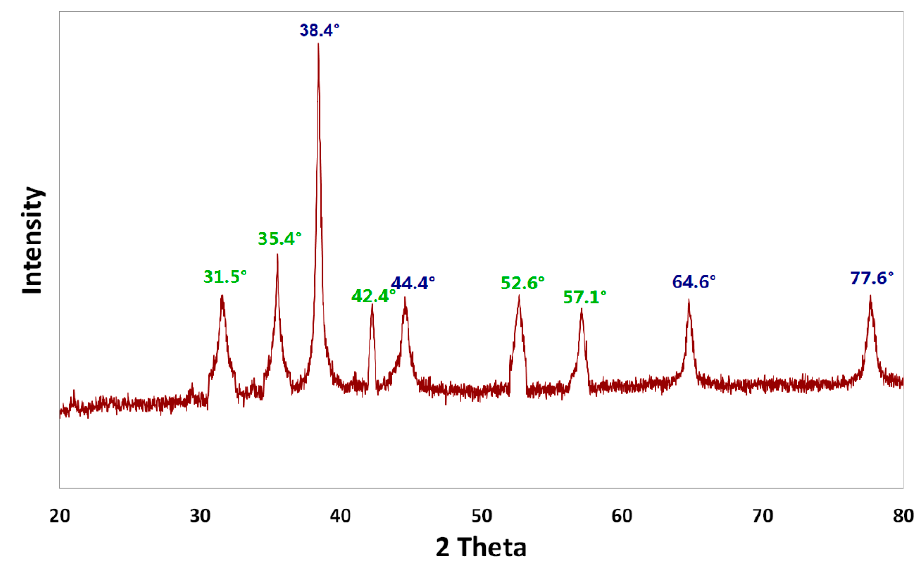
Figure 4. X-ray diffraction (XRD) of the Ag/Fe 2 O 3 synthesized by Buddleja lindleyana extract.